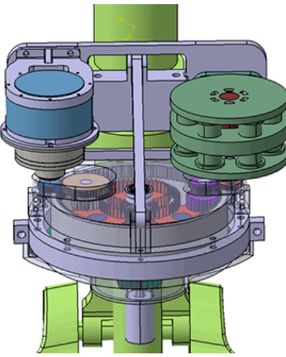
Figure 7. 3D model of the electro-mechanical nose wheel steering system.